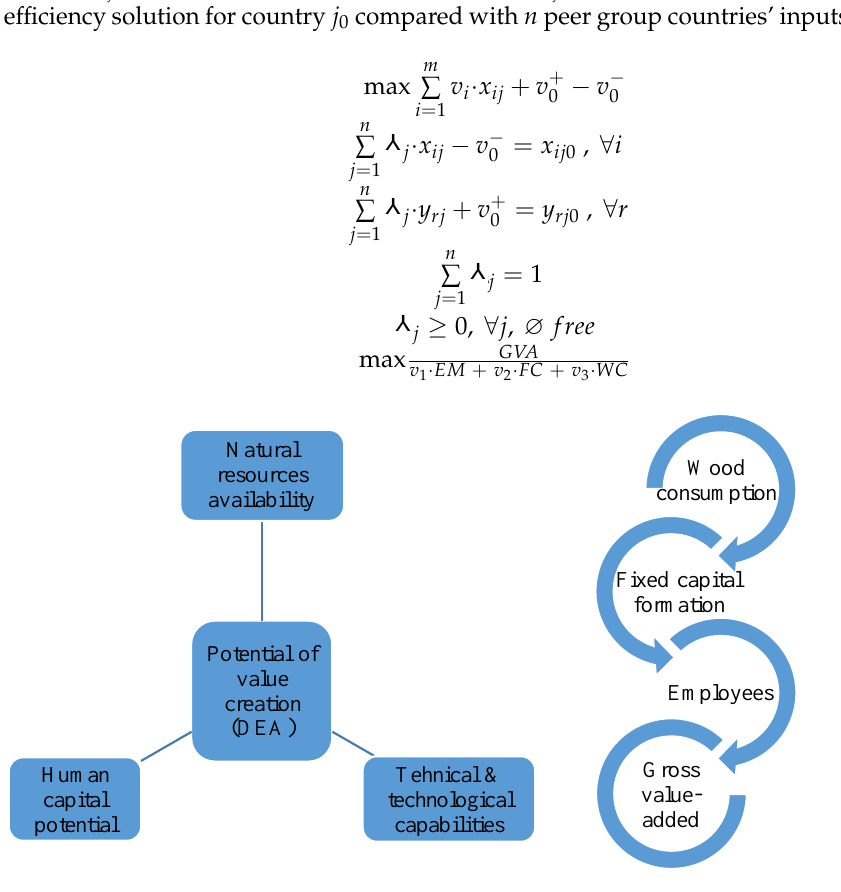
Figure 1. Diagram of the operationalization of potential value creation. Source: authors’ projection.